Question: What form of chart is displayed?
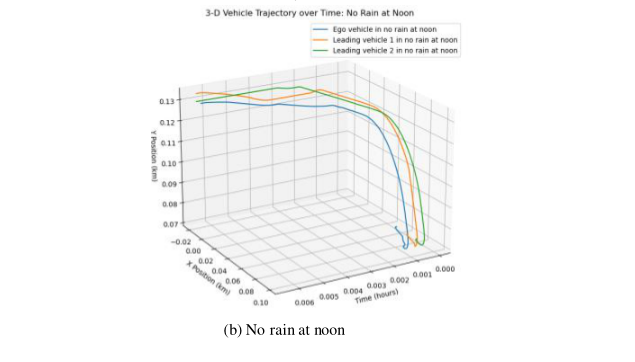
Answer: line